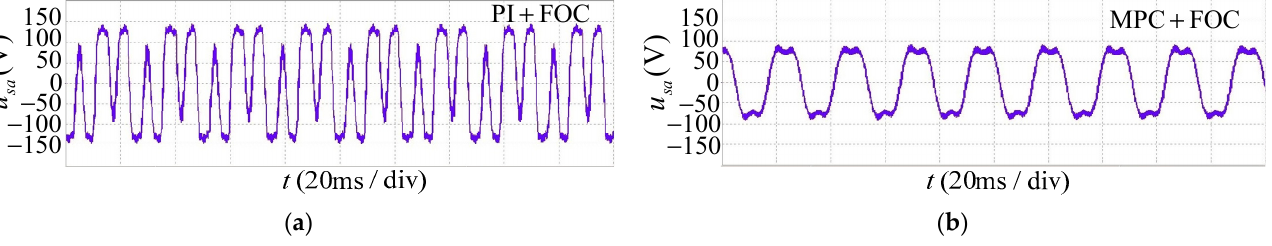
Figure 9. Phase voltage u sa after the filtering of two control methods with a load: ( a ) phase voltage under PI+FOC at a 2 KHz switching frequency; and ( b ) phase voltage under MPC+FOC at a 2 KHz switching frequency.